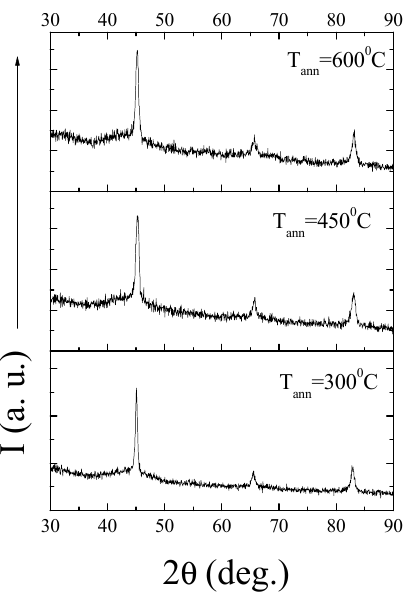
Figure 10. XRD patterns of Hitperm Fe 38.5 Co 38.5 B 18 Mo 4 Cu 1 microwire ( ρ ≈ 0.6) annealed at different temperatures for 1 h. Reproduced from reference [10], Figure 7.